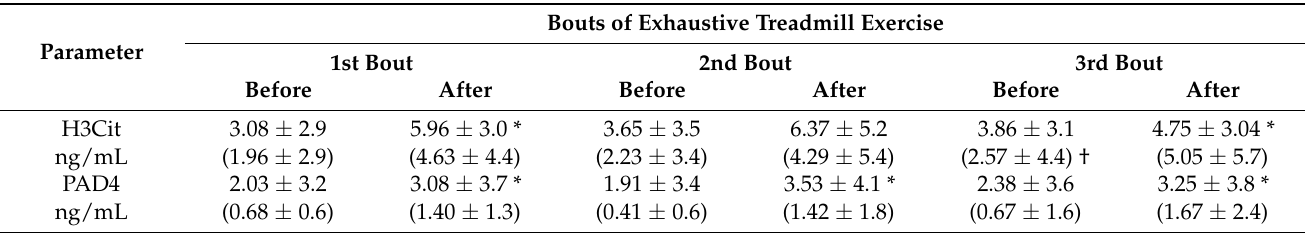
Table 1. Level of H3Cit and PAD4 before and after each of three bouts of exhaustive treadmill exercise. Bouts of Exhaustive Treadmill Exercise Parameter 1st Bout 2nd Bout 3rd Bout Before After Before After Before After H3Cit